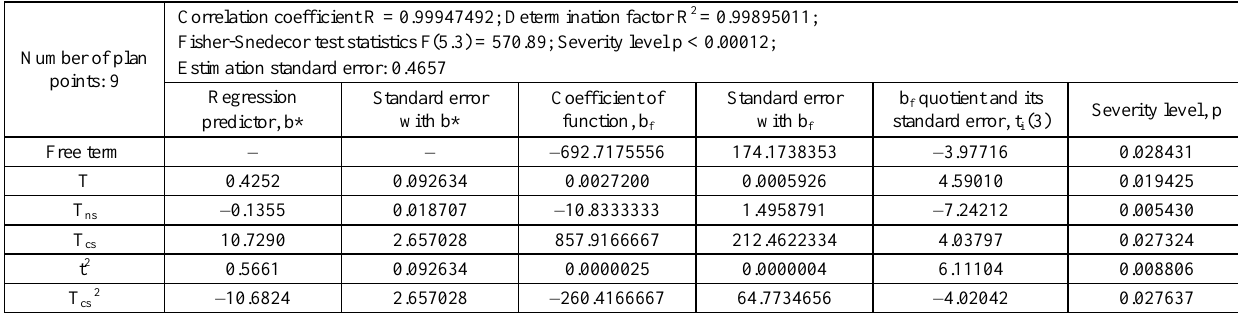
Table 6. Summary of multiple regression in the STATISTICA program